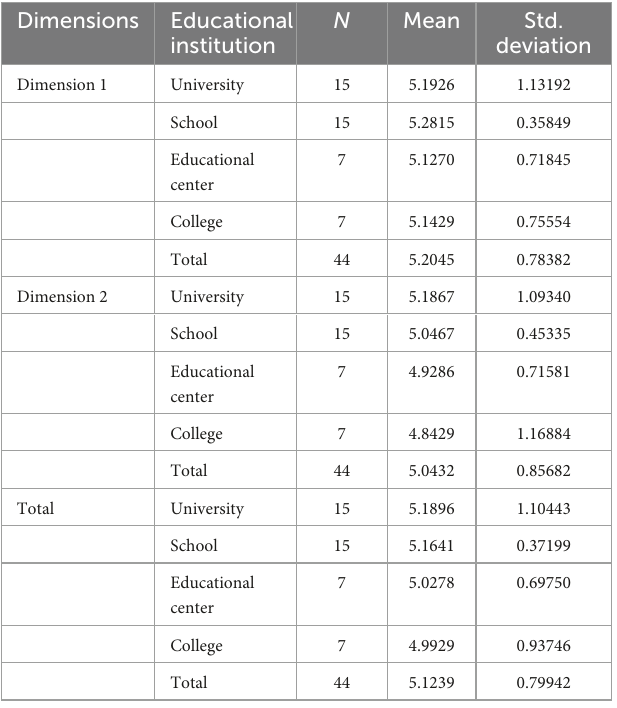
TABLE 8 Mean and standard deviation (based on academic degree).